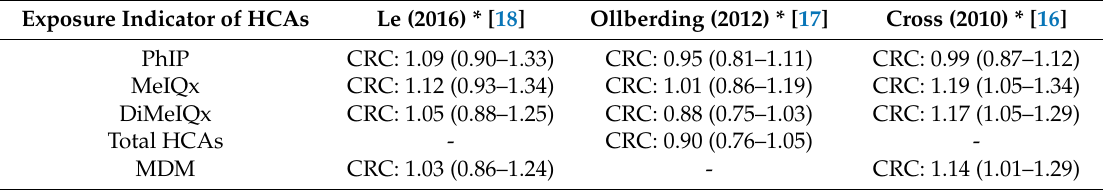
Table 3. Missing data from prospective cohort